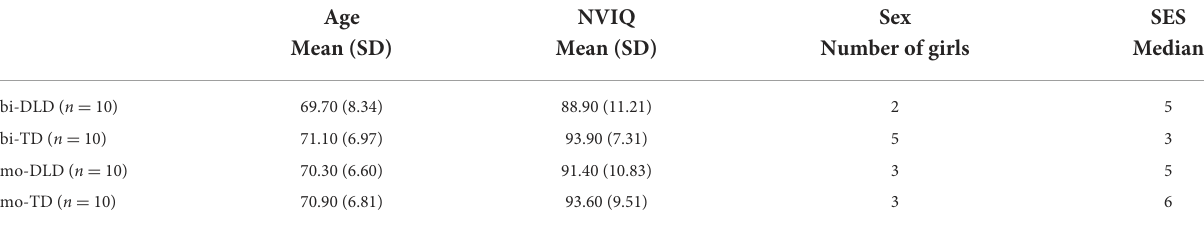
TABLE 1 Demographic characteristics of the four matched